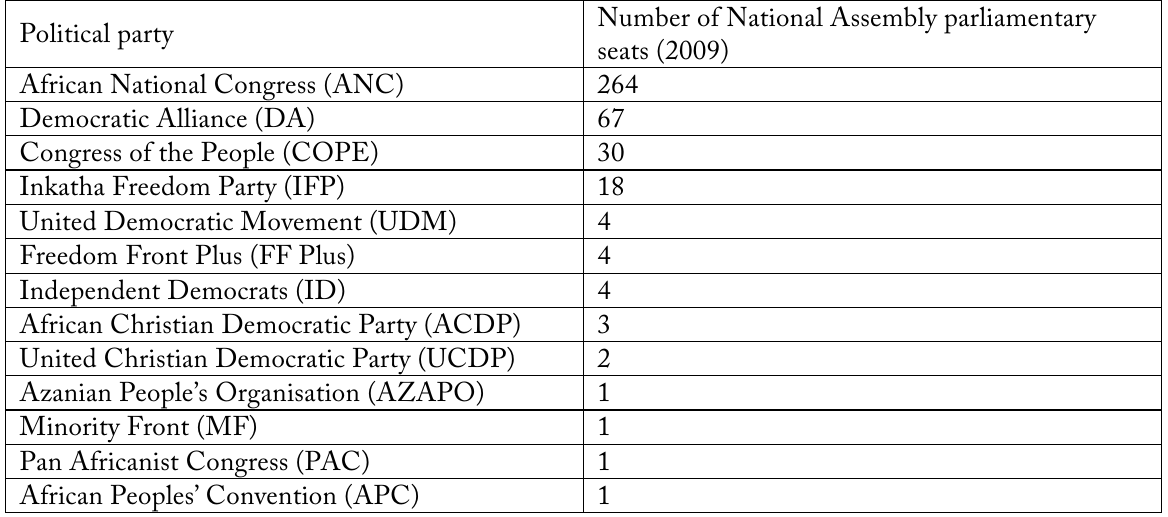
Distribution of the parliamentary seats among the South African political parties (Source: Parliamentary monitoring group,